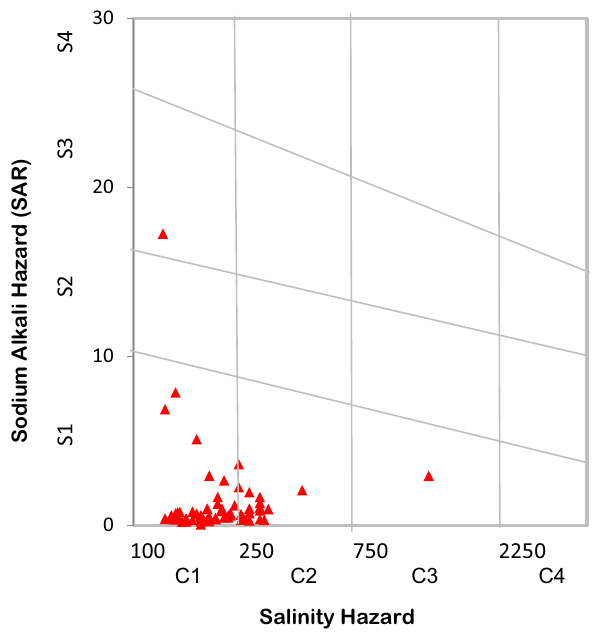
Fig. 7 Graph showing groundwater quality in relation to salinity and sodium hazards (after US Salinity Laboratory 1954)